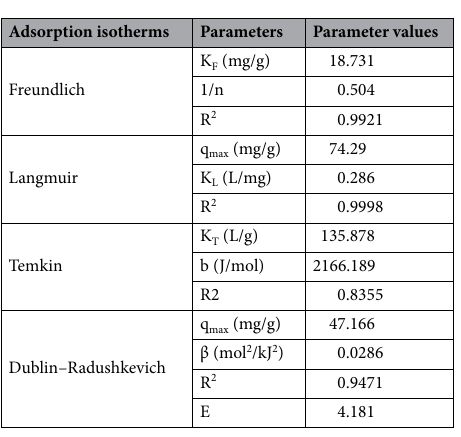
Table 4. Isotherm coefficients and parameters of As(V) adsorption on amino-MIL-68(Al).